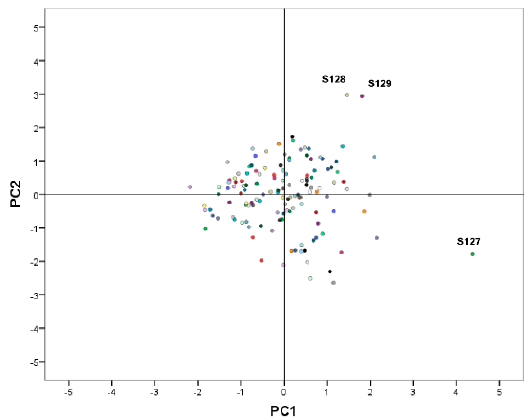
Figure 3. The 2D projection classification map of principal component analysis (PCA) for all the samples.